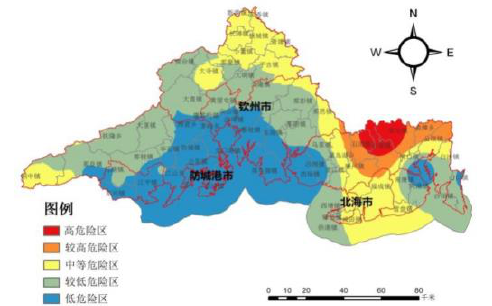
Figure 5. Annual Flood Hazard Distribution in Coastal Areas of Guangxi 4.2.3